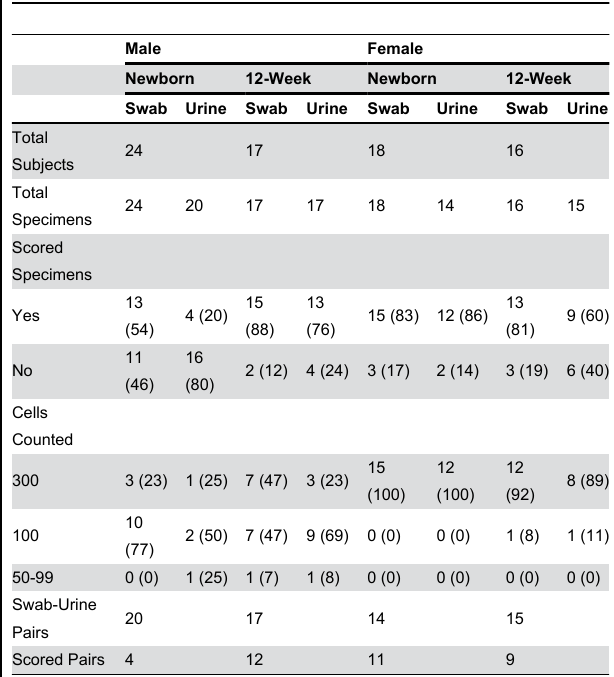
Table 1. Characteristics of evaluated specimens (n= 141), n (%).